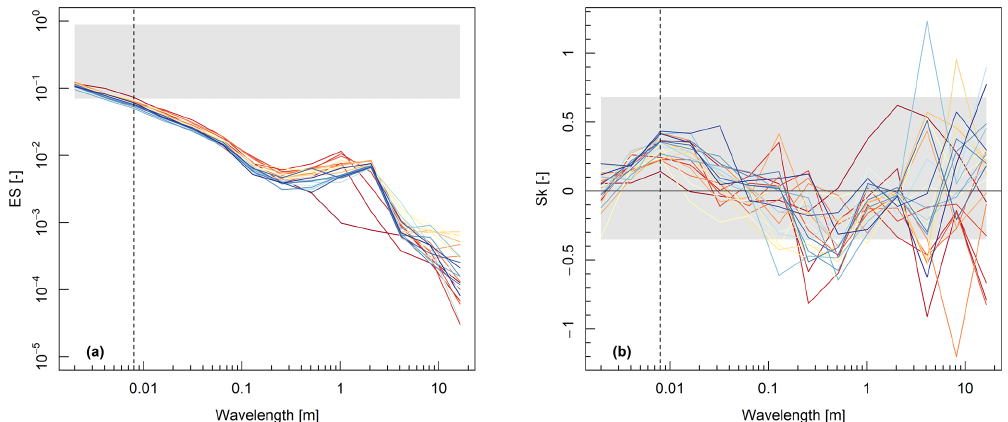
Figure 7. (a) Effective slope and (b) skewness of each topographic wavelength during Experiment 1a. The shaded area represents the range of ES and Sk values of the surfaces generated by Forooghi et al. (2017). Refer to Fig. 6 for